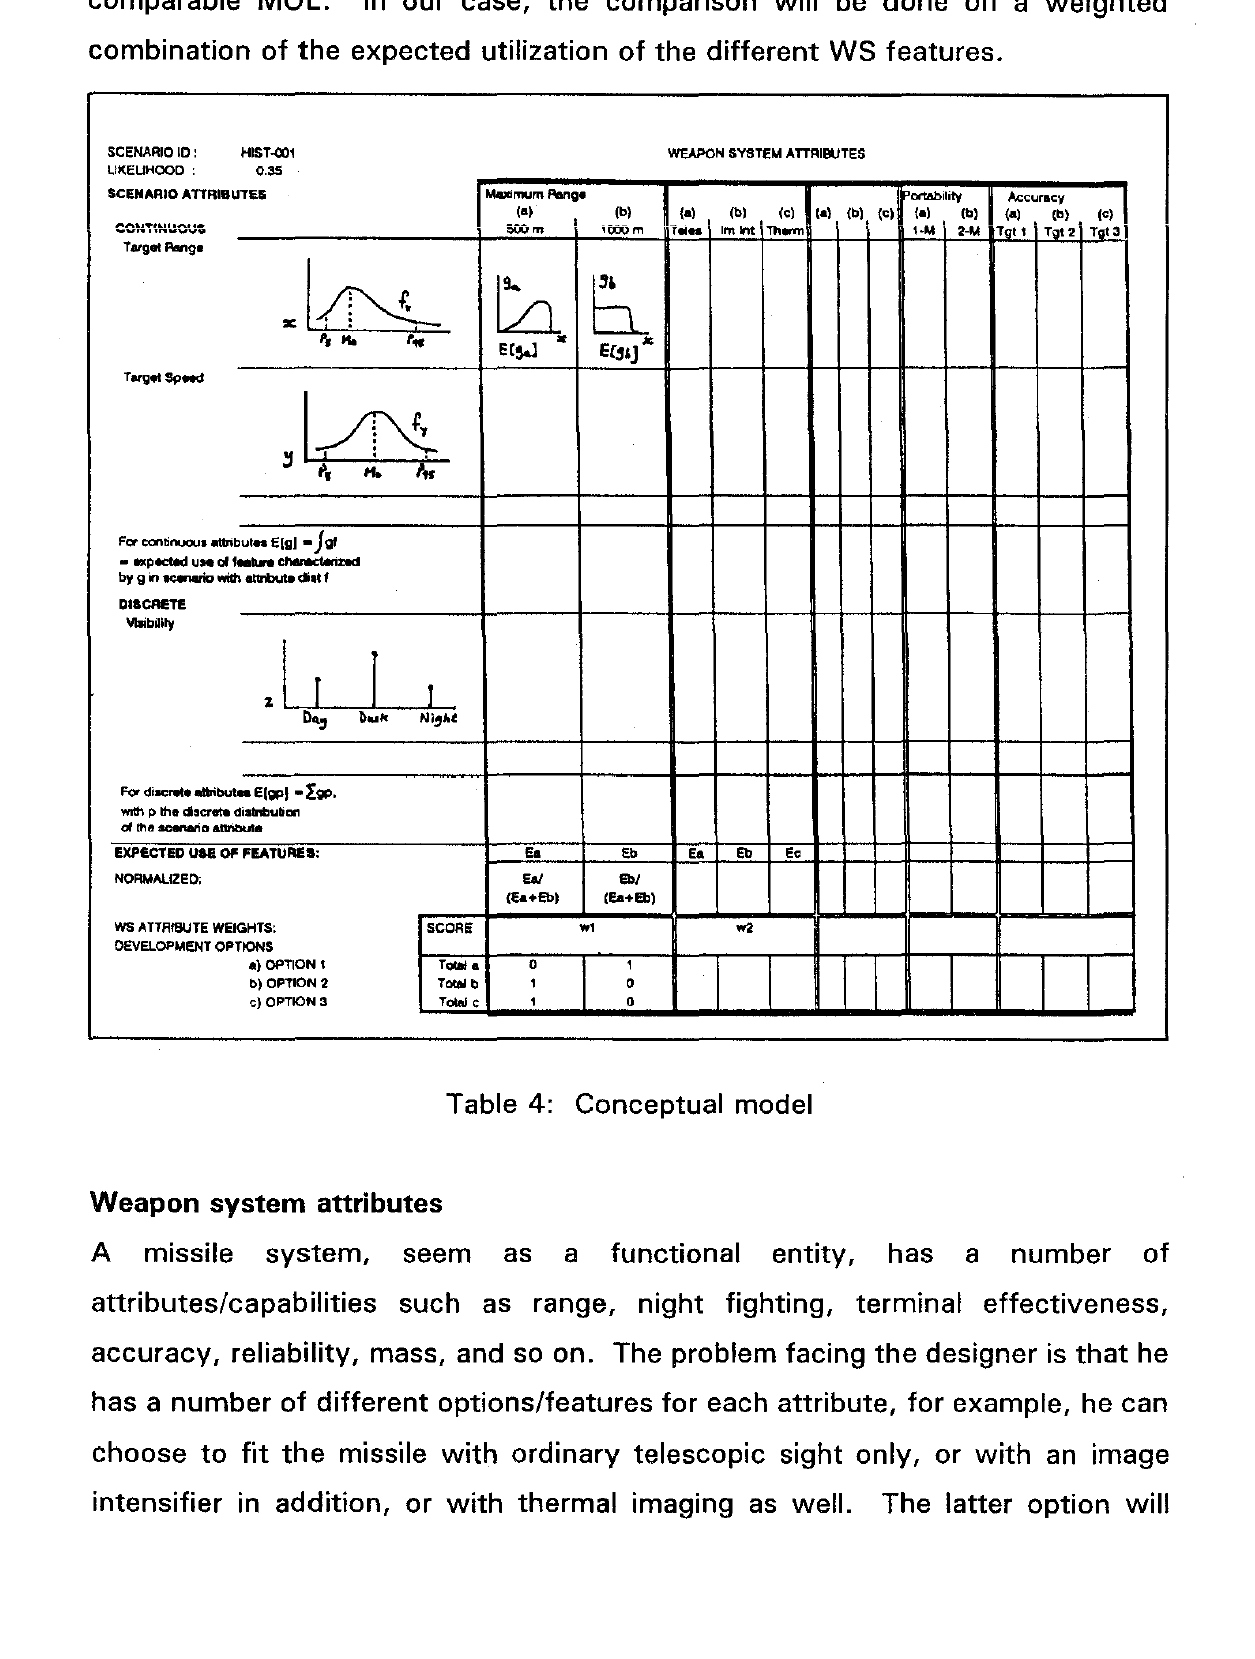
Table 4: Conceptual